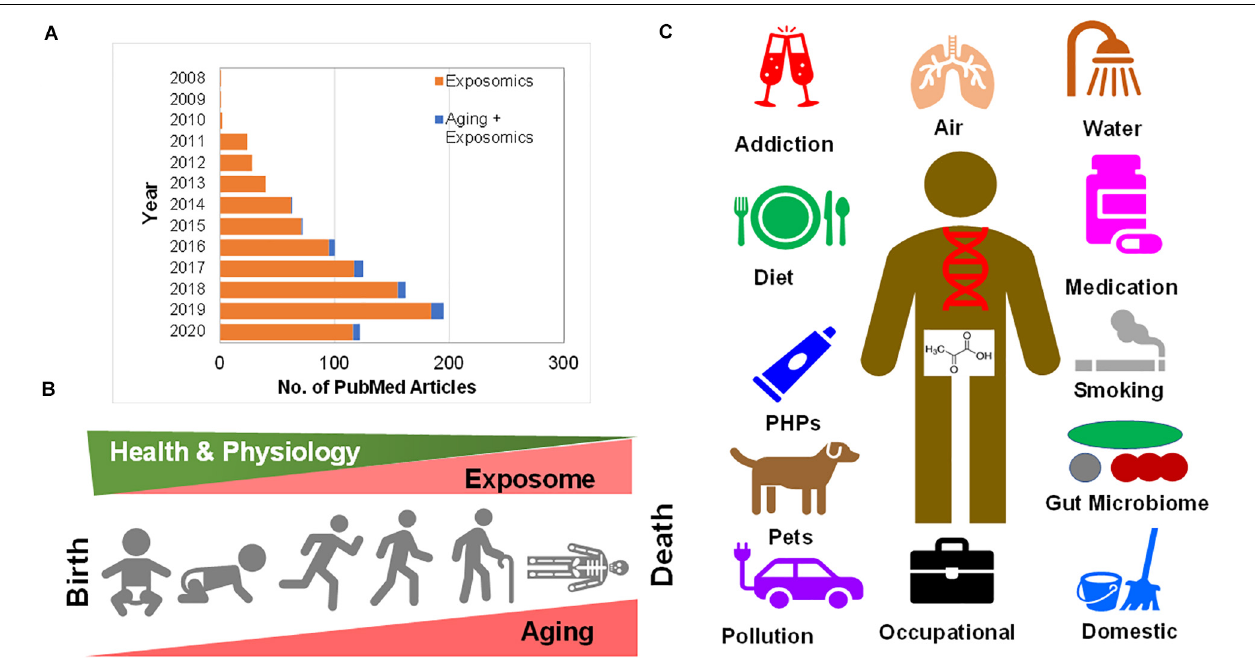
FIGURE 1 | (A) Growth in research publications at PubMed pertaining to “exposomics” and “exposomics and aging” research. (B) Human aging from child birth (neonatal) through adolescence and the ultimate of life, death are riddled with exposure to chemicals surrounding us. As with the incremental aging one experiences physiological decline, possibly the cumulative exposome increases inside human body. (C) Human chemical exposure ranges from addiction (alcohol, drugs, cocaine, and smoking), to air pollution (PM, gases, industrial vapors), water (pollutions, pesticides, and PFAS), drugs (pharmaceuticals, and medications), the resident internal and external gut microbiome, domestic waste and indoor pollution (dust, cooking, and gases), occupational exposures (hospital disinfectants to asbestosis), pollution (fossil fuel burning to plastic), pets (carrying environmental pollution to microbiome), personal hygiene products (PHPs) (perfumes to soaps) to diet (and